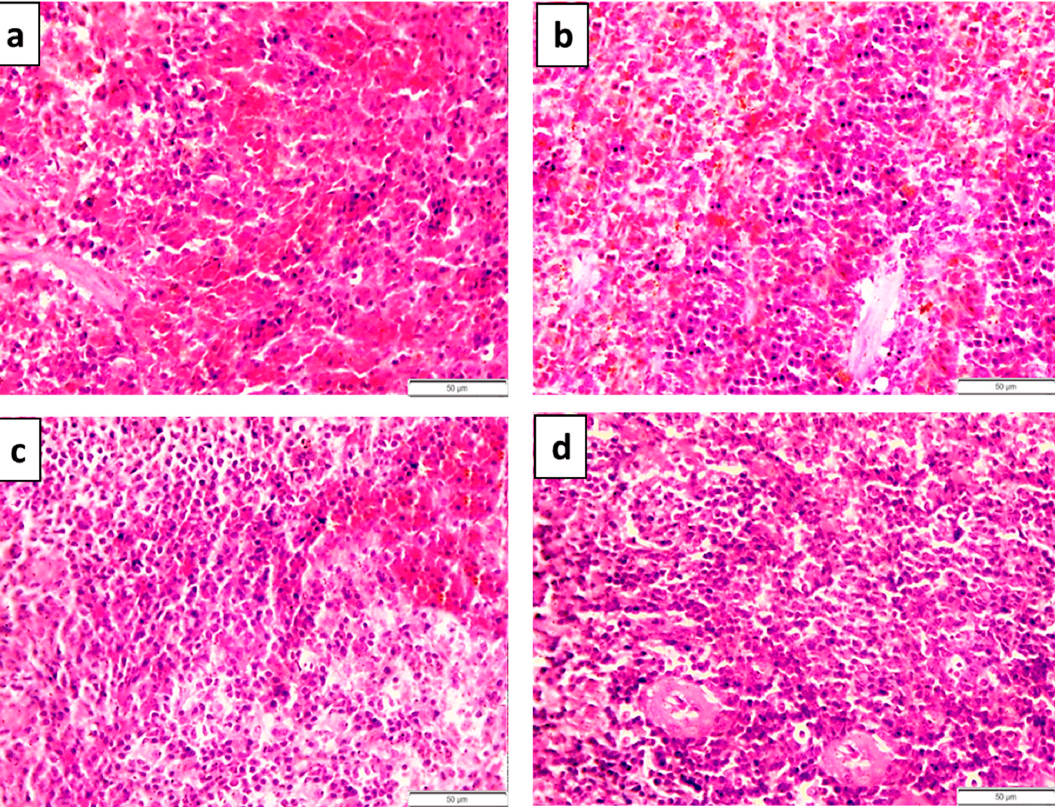
Figure 6. Histopathological features of spleen in lead-acetate-induced anemic rats ( a , b ) treated with 27 ppm/day iron oxide nanoparticles ( c ) prepared chemically or ( d ) green biosynthesized with Petroselinum crispum leaf extract for 6 weeks. ( a ) Extensive diffuse areas of hemorrhages in the red pulp. ( b ) Lymphoid depletion of the white pulp. ( c ) Mild lymphoid depletion of the white pulp. ( d ) Mild congestion of blood vessels of red pulp and normal lymphoid follicles of white pulp.